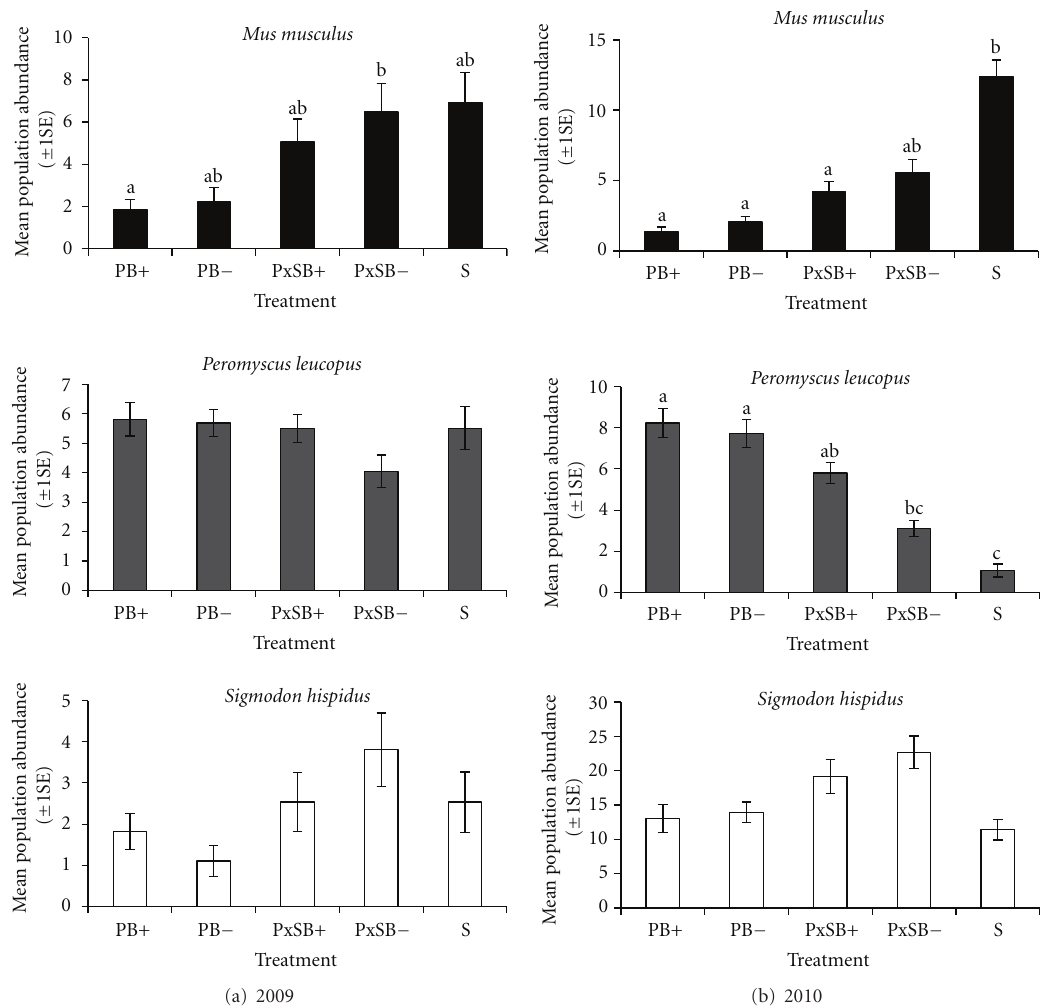
Figure 4: Population abundance estimates from Program MARK (mean number of adult individuals/plot, ± 1 standard error; n = 4) for Mus musculus, Peromyscus leucopus, and Sigmodon hispidus by treatment in (a) 2009 and (b) 2010 at the Lenoir 1 Sustainability Study Site, in Lenoir Co, NC. y -axes vary between plot (a) and (b) to improve readability. Treatments: PB+ = Pine Biomass+; PB − = Pine Biomass − ; P × SB+ = Pine × Switchgrass Biomass+; P × SB − = Pine × Switchgrass Biomass − ; S = Switchgrass. Treatments with di ff erent letters are significantly di ff erent ( P < 0 . 05; Tukey’s post hoc tests). Rodents were captured and released during 15 July–9 December, 2009 and 19 July–14 November,